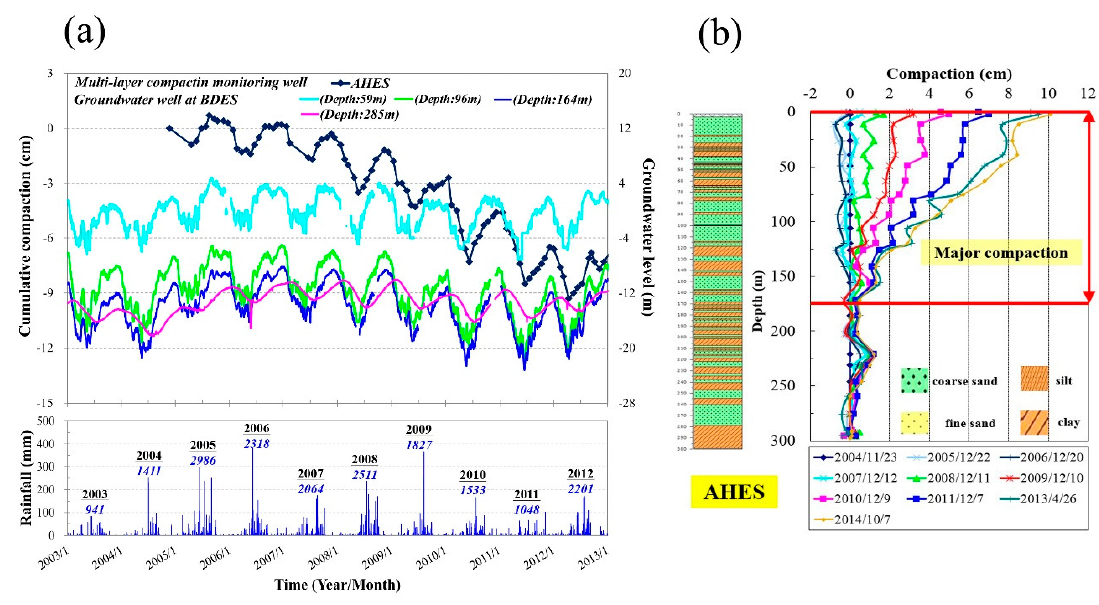
Figure 6. ( a ) Cumulative compactions, groundwater levels and rainfalls at inland station AHES ( b ) Cumulative compactions at inland station AHES.